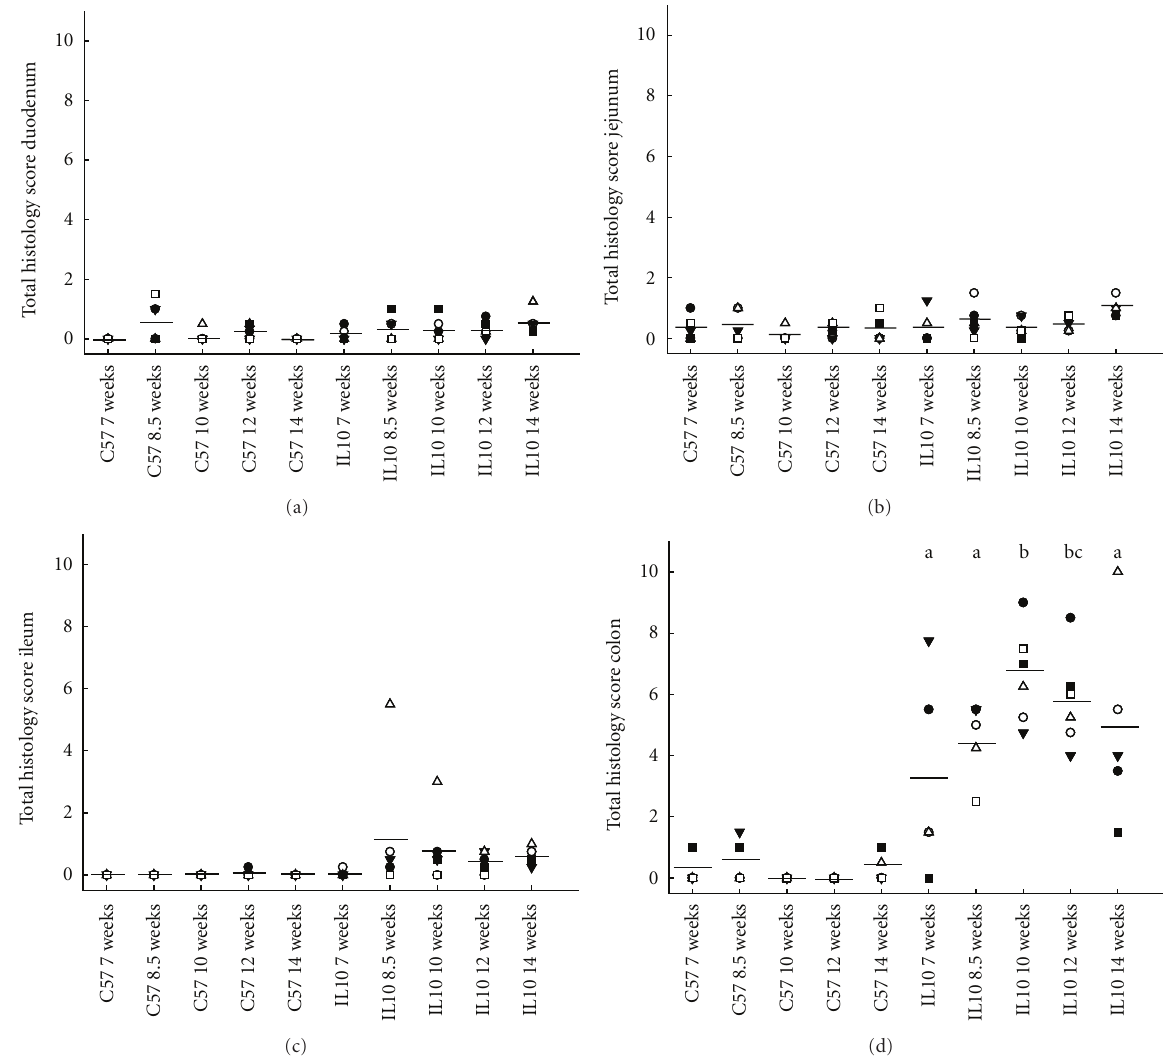
Figure 1: Total histological injury score for duodenum, jejunum, ileum, and colon sections of Il10 − / − and C57 mice at 7, 8.5, 10, 12, and 14 weeks of age. The individual scores and the average score (—) of each sampling group are shown. Statistical analysis was performed only for total colon HIS of Il10 − / − mice and di ff erent letters mean that total colon HIS di ff ers compared to 7-week-old Il10 − / − mice (a, b, P < 0 . 05 and c, 0 . 05 < P < 0 .